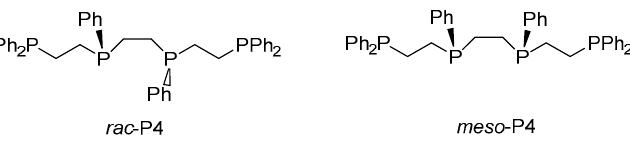
Figure 3. Structures of rac- and meso